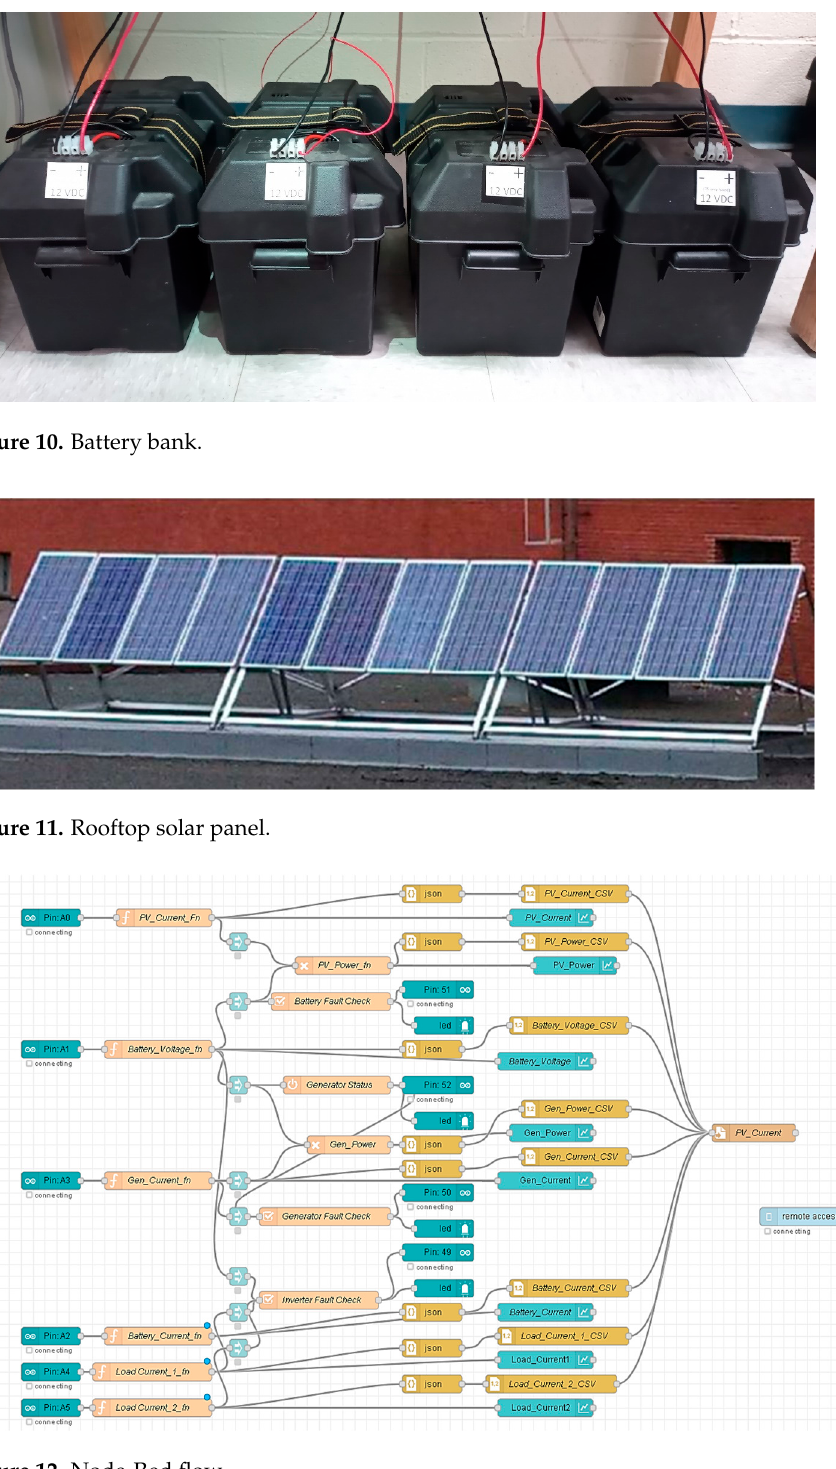
Figure 12. Node-Red flow.